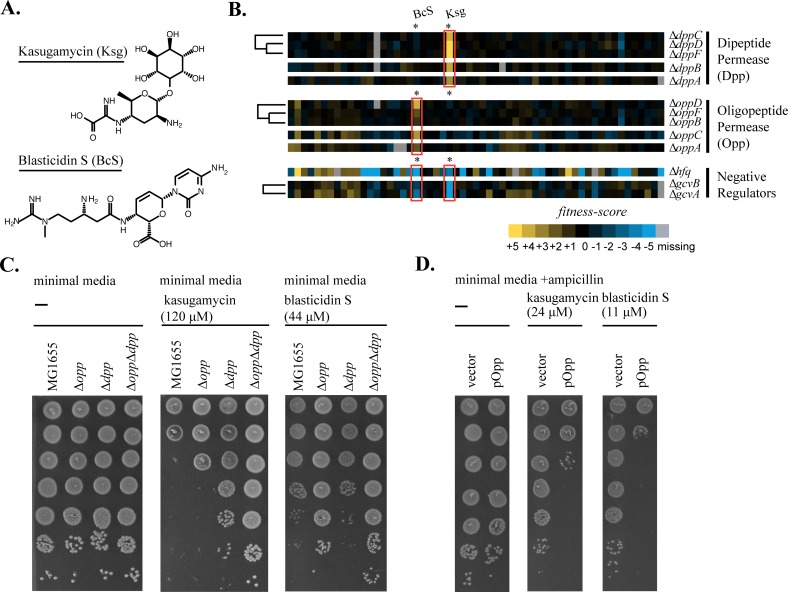
Peptide ABC-importers determine susceptibility to kasugamycin and blasticidin S in E. coli K-12.(A) Structures of kasugamycin (Ksg) and blasticidin S (BcS). (B) Deletions of peptide importer genes are resistant to kasugamycin and blasticidin S. The heat-map of fitness-scores for dipeptide permease (ΔdppA, ΔdppB, ΔdppC, ΔdppD, and ΔdppF), oligopeptide permease (ΔoppA, ΔoppB, ΔoppC, ΔoppD, and ΔoppF), and their negative regulators (Δhfq, ΔgcvA, and ΔgcvB) for the entire set of new stresses is shown. Ksg and BcS are highlighted within the heatmap. (C) Deletions of each peptide permease operon show an increase in resistance to Ksg and BcS. 10-fold spot dilutions are shown for operon deletions Δopp, Δdpp and the double mutant Δopp Δdpp (D) Overexpression of opp results in a decrease in resistance to Ksg and BcS. 10-fold spot dilutions of cells with the high copy vector pDSW204 containing the opp operon (pOpp) grown without induction indicate decreased resistance to both Ksg and BcS relative to the empty vector control (vector).